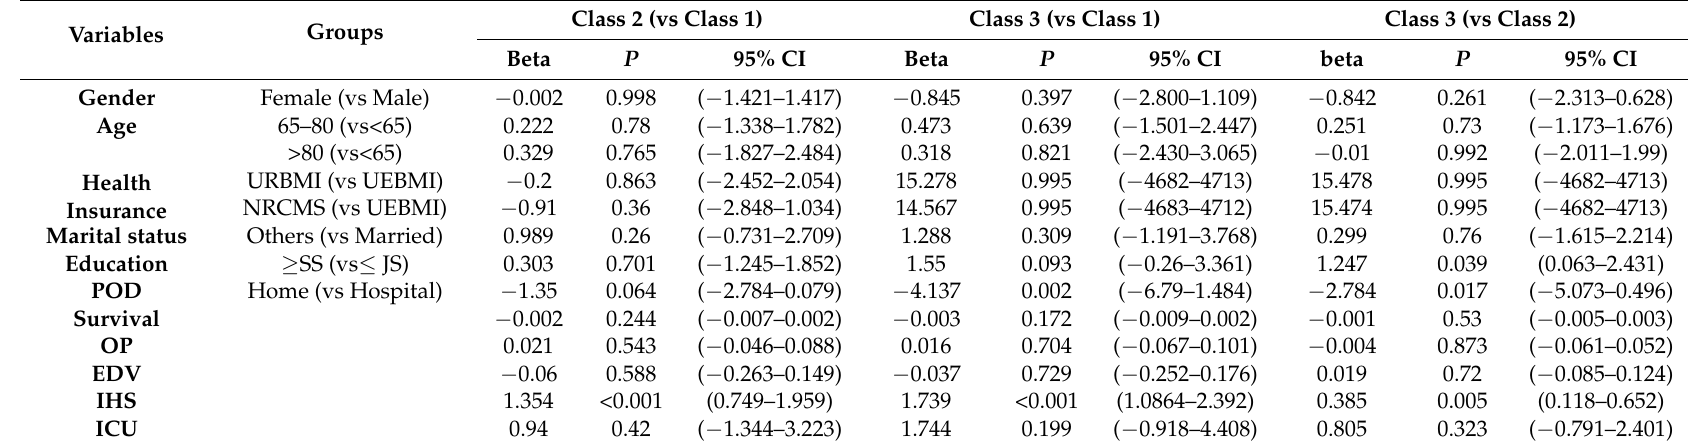
Table 3. Determinants of the membership in the different